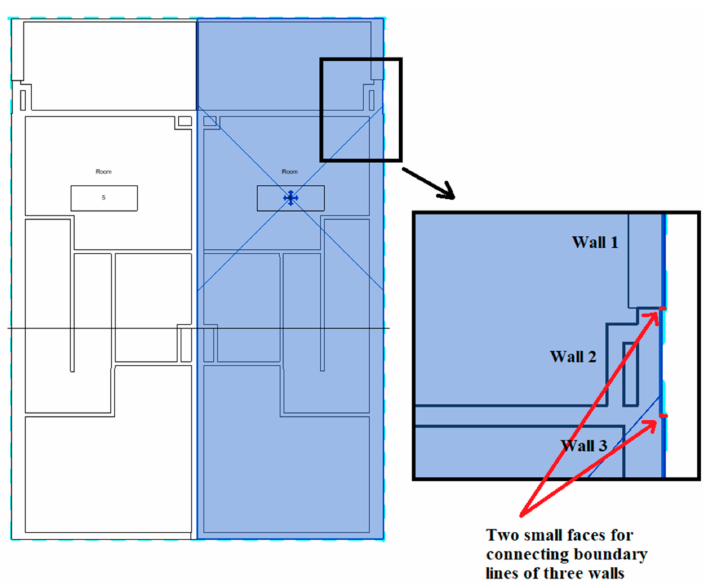
Figure 31. Problem with defining an Exterior boundary associated with three different types of walls with different thicknesses.